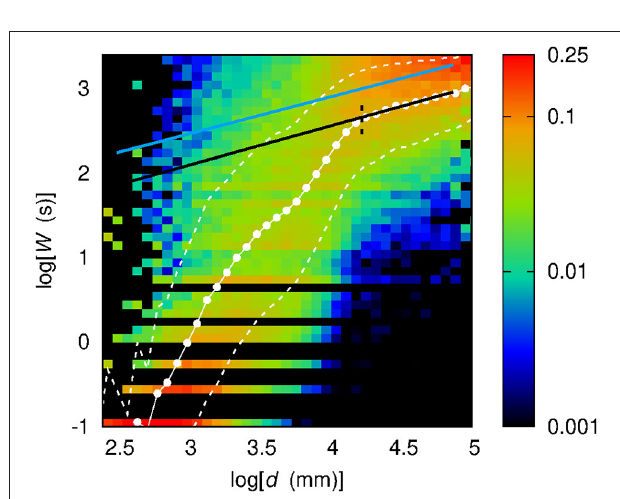
FIGURE 9 | Conditional sample distribution f (log W | log d ) of log W given log d obtained by partitioning both the log d range and the log W range in 50 bins. White dots show the average value log W of log W given log d . White dashed lines bound the 68% confidence region for log W , namely the region within 1 σ from the average log( W ). The black dashed line corresponds to the log d value marking the separation between the second and third regimes. The black solid line stems from a best-fit procedure of the same power-law equation on points belonging to the third regime. The light blue solid line shows the results of the analysis from a previous work (Perinelli et al., 2019) concerning a power-law relationship between W and d